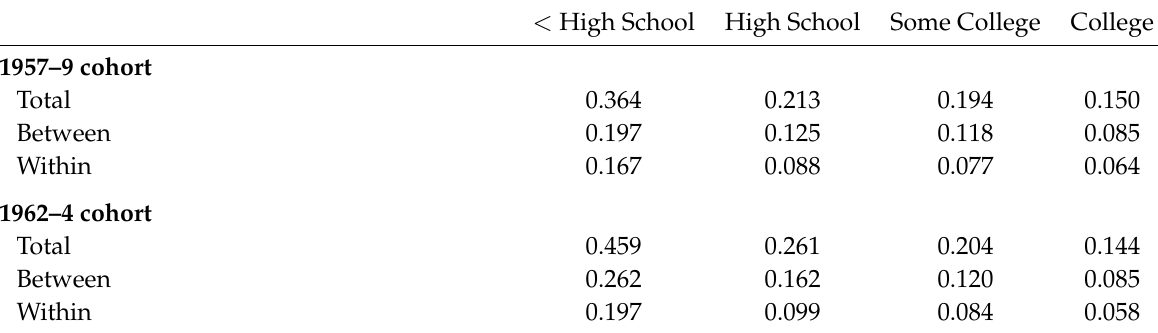
Table 5: Decomposition of Half the Squared Coefficient of Variation Within Educational